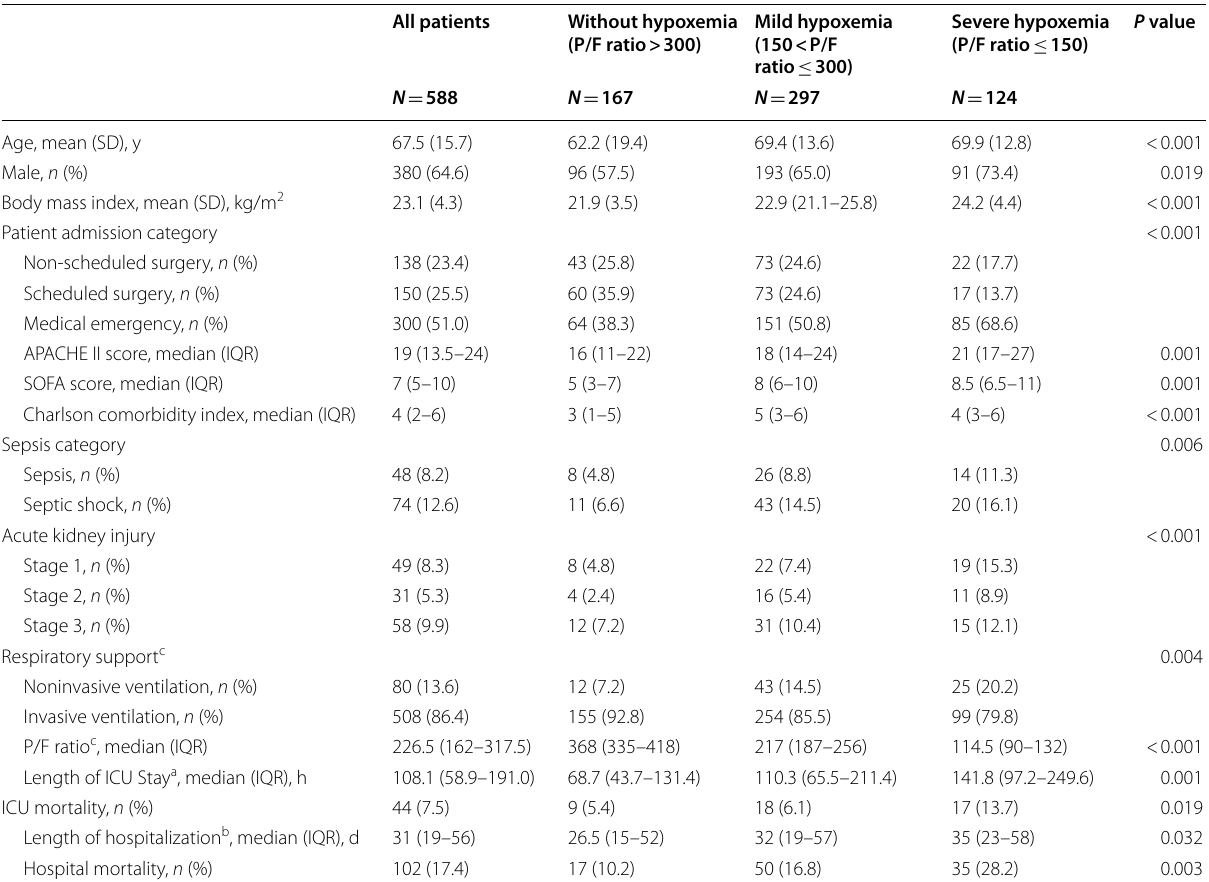
Table 1 Characteristics of patient population, days of hospital stay,